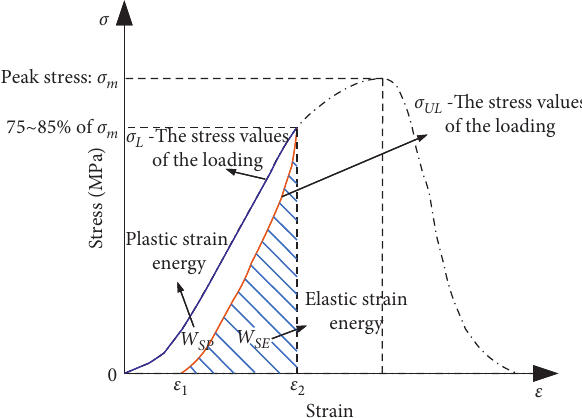
Figure 8: Schematic of elastic strain energy index